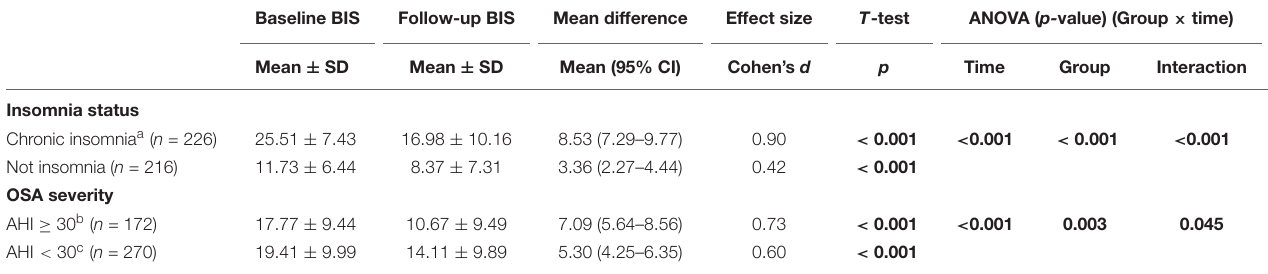
TABLE 4 | Comparison of BIS scores at baseline and follow-up depending on insomnia diagnosis and severity of OSA in 442 Norwegian patients treated with CPAP. Baseline